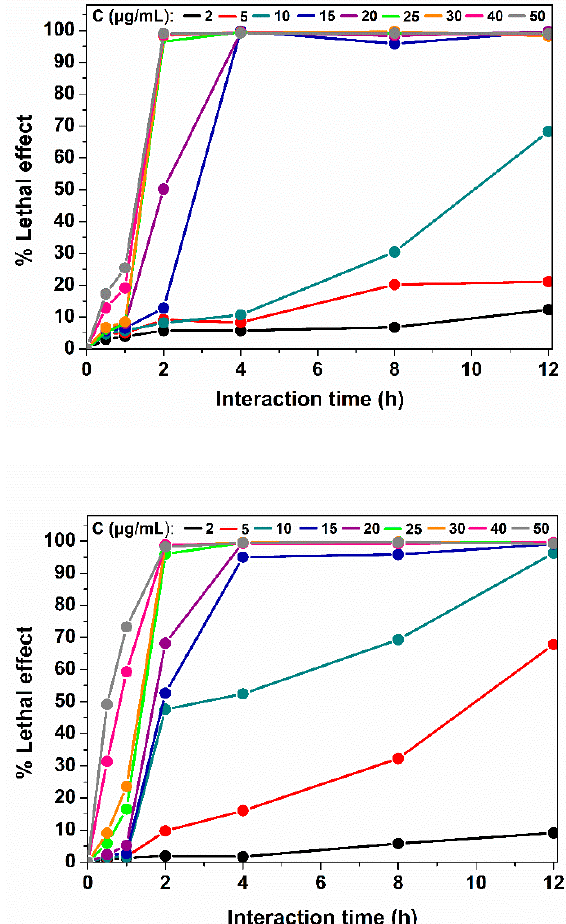
Figure 10. Lethal effect of synthesized AgNPs on E. coli ( top ) and C. glutamicum ( bottom ) cells under different concentrations and interaction times. All measurements were in triplicates while the standard deviation is represented.